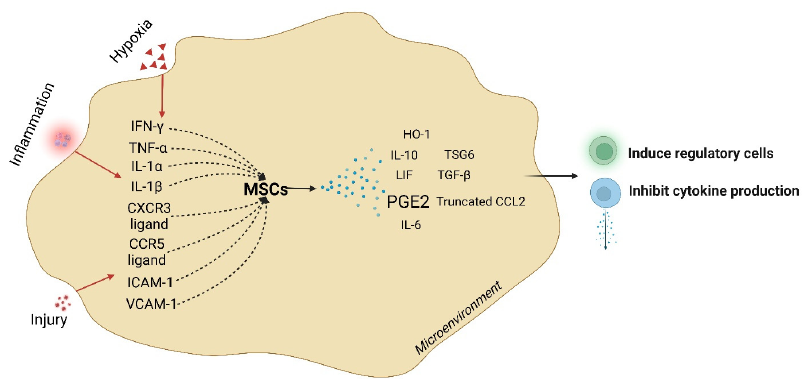
Figure 2. Communication of MSCs in Damaged Tissue and the Immunosuppression Property of MSCs. Tissue injury, inflammation, and hypoxia factors cue a signal that mobilizes MSCs to the damaged tissue. Once MSCs enter the microenvironment of the injured tissue, IFN γ , together with pro-inflammatory cytokines, such as TNF α , IL-1 α , and IL-1 β , the occurrence of a burst of chemo- kine, and the expression of adhesion molecules, stimulate MSCs to release large amounts of immu- nosuppressive factors. These immunosuppressive factors then promote the activation of immune cells, which induce regulatory cells and inhibit cytokine production. This figure was created using the BioRender online app and license.